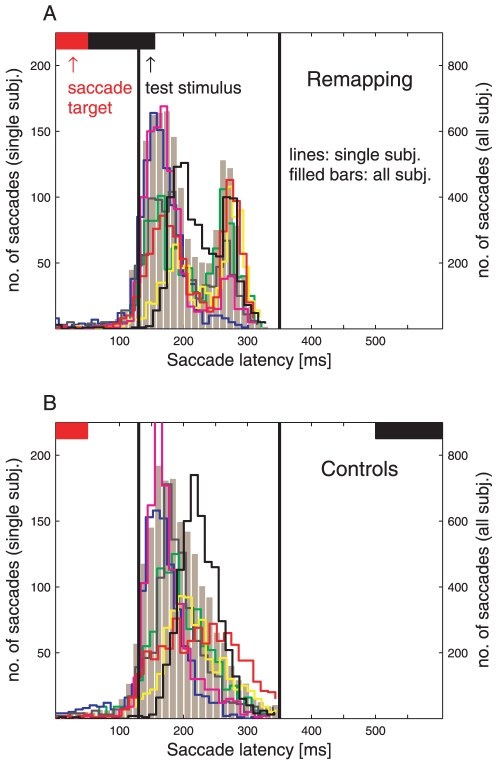
Saccade Latencies in the Remapping Experiment.Number of saccades in each subject (scale on left y-axis) and mean of all
subjects (scale on right y-axis) are plotted against saccade latency.
Total saccade count is shown as ochre bar histogram. For clarity,
histograms of single subjects are depicted by colored stair functions.
All histograms are made up of 35 bins, equivalent to a bin size of
approximately 11 ms. The horizontal red and black bars depict times of
saccade target and test stimulus presentation. The two black vertical
lines enclose the interval of saccade latencies chosen for analysis.
A Saccade latencies for trials with a delay period of
50 ms (remapping conditions). B Saccade latencies for
trials with a delay period of 500 ms (control conditions).